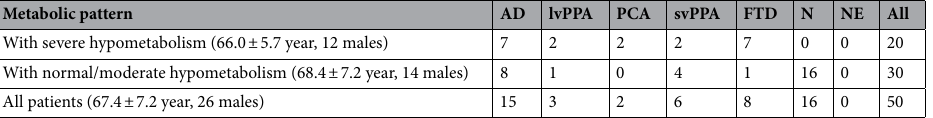
Metabolic pattern